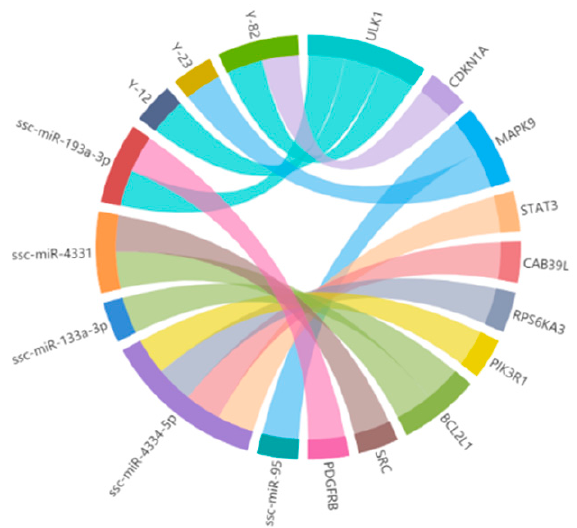
Figure 4. Predicted relationship of screened candidate miRNA and targeted gene of PPI network.